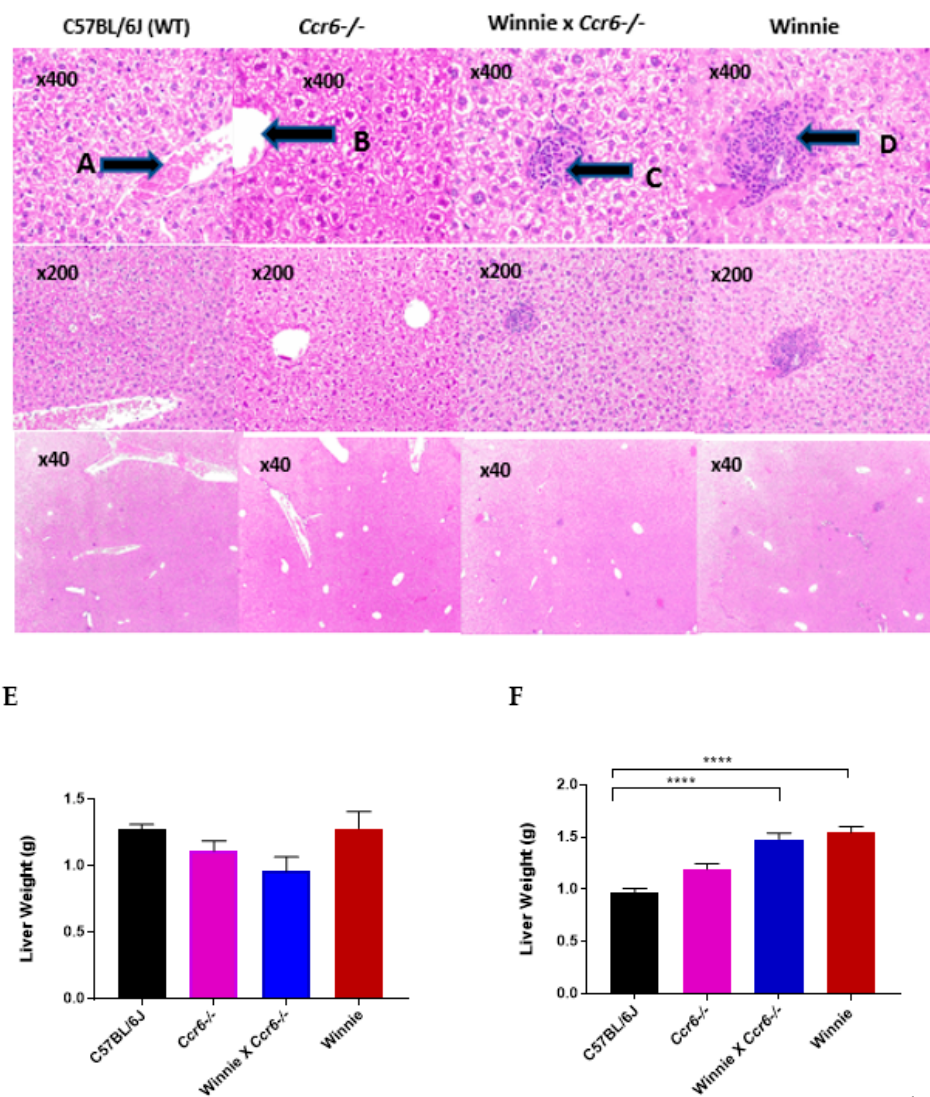
Figure 5. Representative images of H&E in liver histology in the four genotypes at 16–22 weeks of age. Arrows indicate ( A ) portal tract, ( B ) central canal, ( C ) immune cell infiltration indicative of focal lobular inflammation in Winnie × Ccr6 − / − , ( D ) severe focal lobular inflammation in Winnie, ( E ) comparison of liver weight in the four genotypes at 8 weeks of age, ( F ) comparison of spleen weight in the four genotypes at 16–22 weeks of age. Data expressed as Mean ±SEM by one-way analysis of variance (ANOVA) and Tukey’s multiple comparison test, n = 7 per group. p ≤ 0.0001 (****). Inflammation was quantified in the genotypes by counting the numbers of immune